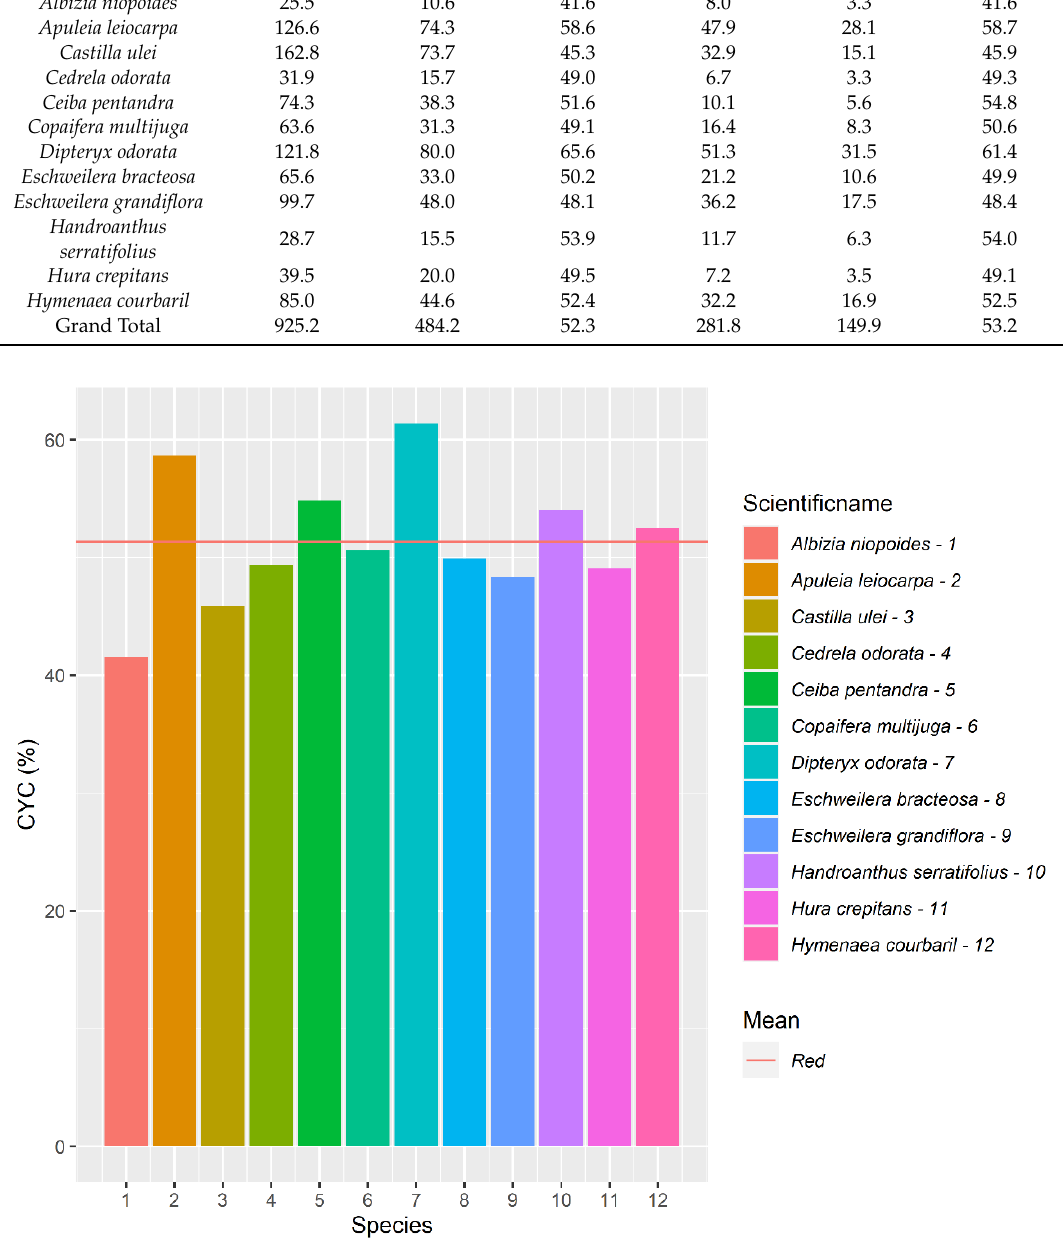
Figure 3. Carbon yield coefficient (CYC; %) on the y-axis and the number for each tree species on the x -axis (given in the legend, together with the colors that correspond to the different species). The results revealed that the average final carbon stock per harvested tree in sawn-wood products from the di ff erent species ranged from 0.4 ± 0.1 MgC to 2.9 ± 0.4 MgC, with the highest percentages of the total wood-product carbon stock being for Dipteryx odorata (21.0%), Apuleia leiocarpa (18.7%), and Eschweilera grandiflora (11.7%) (Table